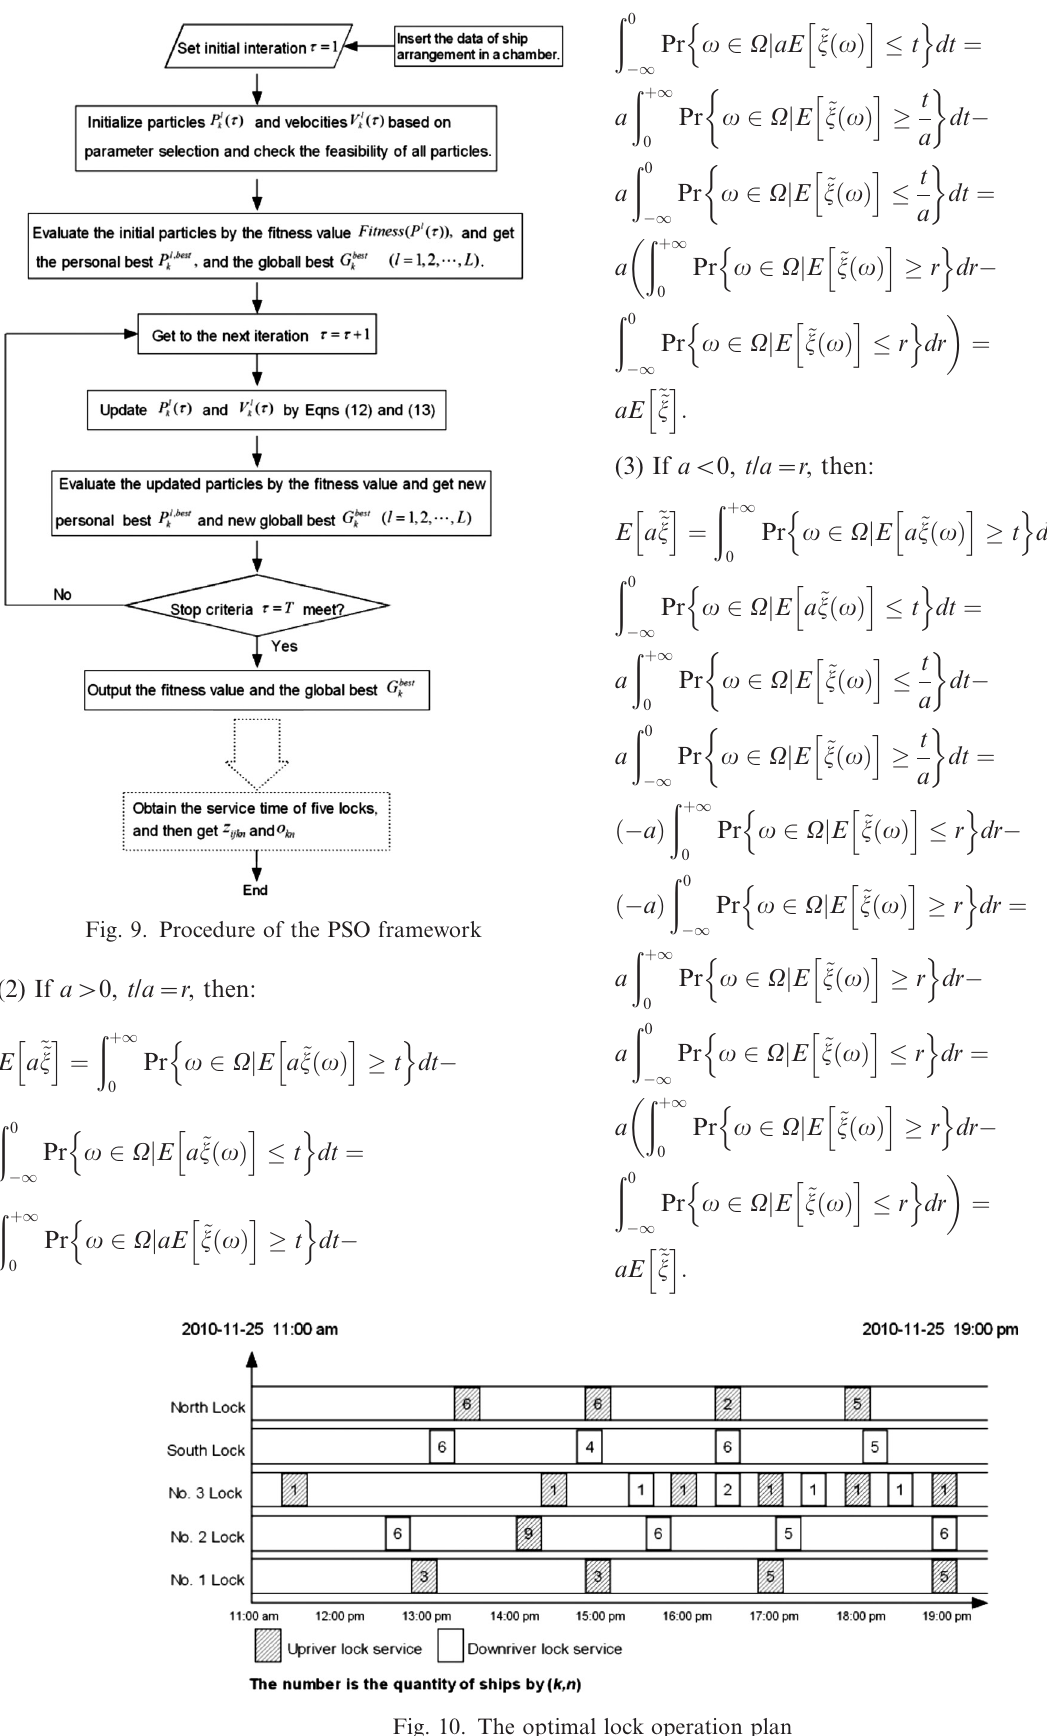
Fig. 10. The optimal lock operation